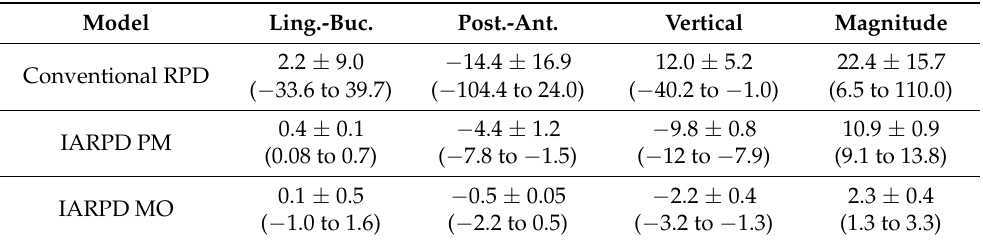
Table 6. Displacements of the abutment teeth in all three directions, X, Y and Z, corresponding to lingual–buccal, posterior–anterior and vertical, respectively, and the corresponding magnitude. Mean ± SD (Min–Max) ( µ